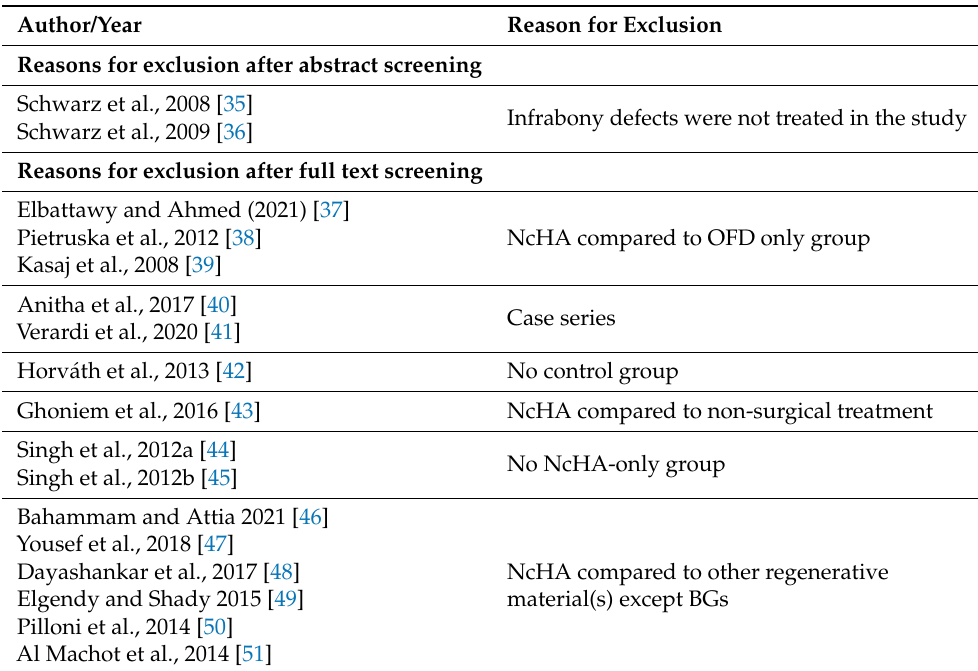
Table 1. Excluded studies with